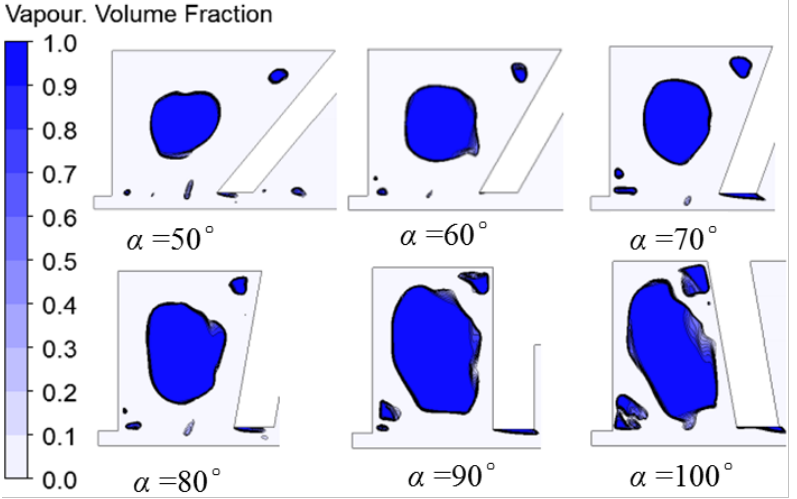
Figure 20. Steam pocket regions of the nozzle with different wall reflection angles.